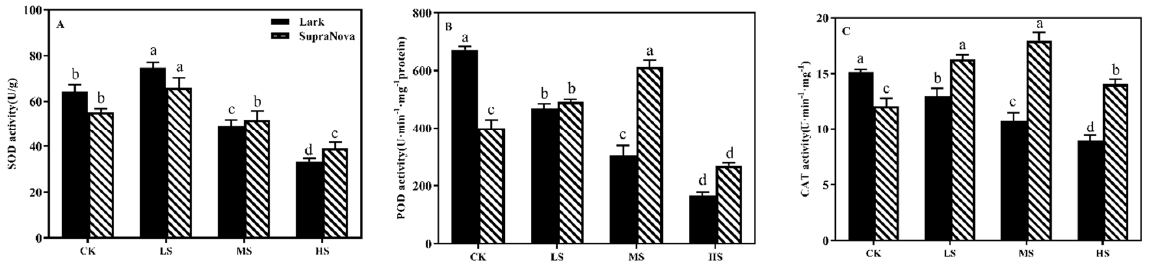
Figure 6. SOD, POD, and CAT activities of two species under different shade treatments ( A – C ). The lowercase letters denote significant differences ( p < 0.05) for the same species. CK = unshaded; LS = 35% shaded; MS = 70% shaded; HS = 92% shaded. The black box represents the species ‘Lark’ and the striped box represents the species ‘SupraNova’.